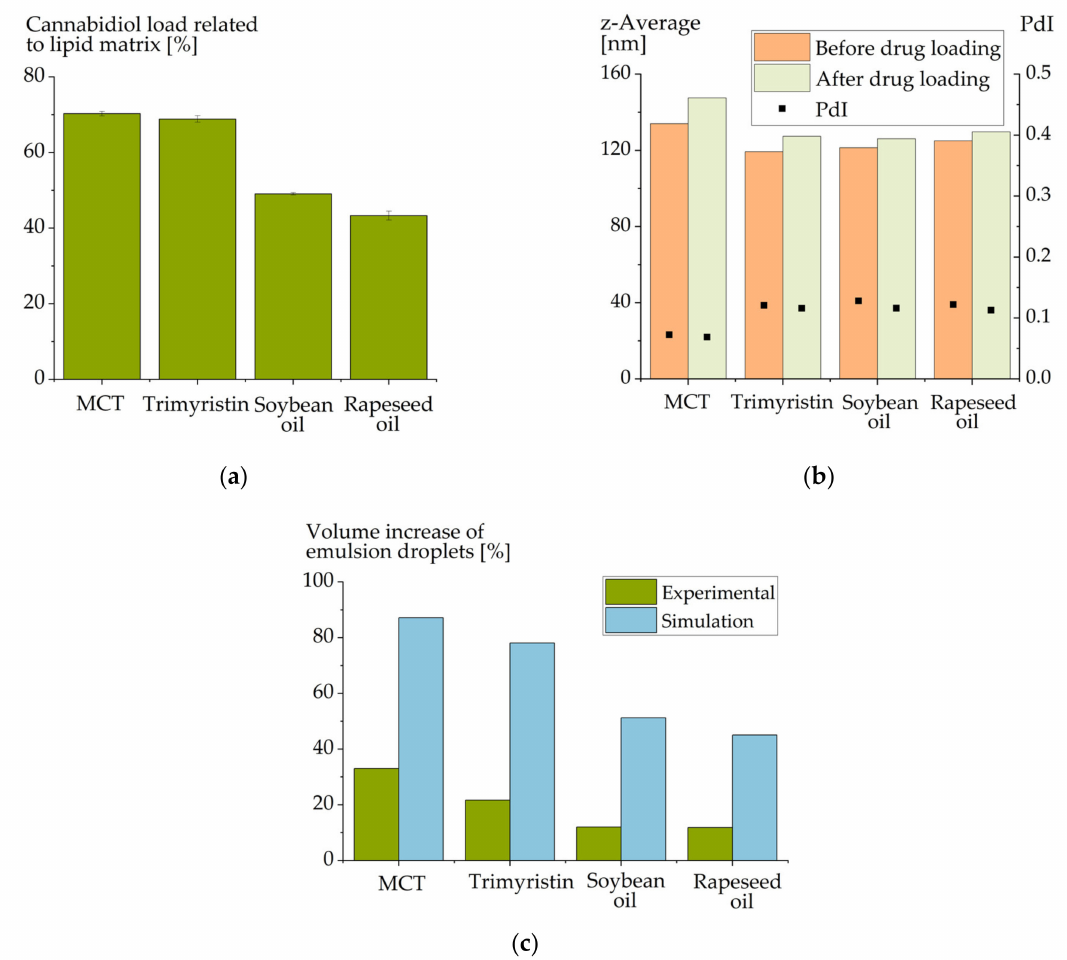
Figure 2. ( a ) Achievable cannabidiol load (mass percent) in emulsions composed of different matrix lipids (emulsions MCT-P188-120 nm, TM-P188-120 nm, SB-P188-120 nm and RS-P188-120 nm). ( b ) Particle sizes of these emulsions before and after cannabidiol loading. ( c ) Experimentally observed increase in the volumes of the emulsion droplets as compared to a simulated volume increase based on the molecular volume of the loaded cannabidiol molecules. The molecular volume was based on the van der Waals surface which was computed with MOE Version